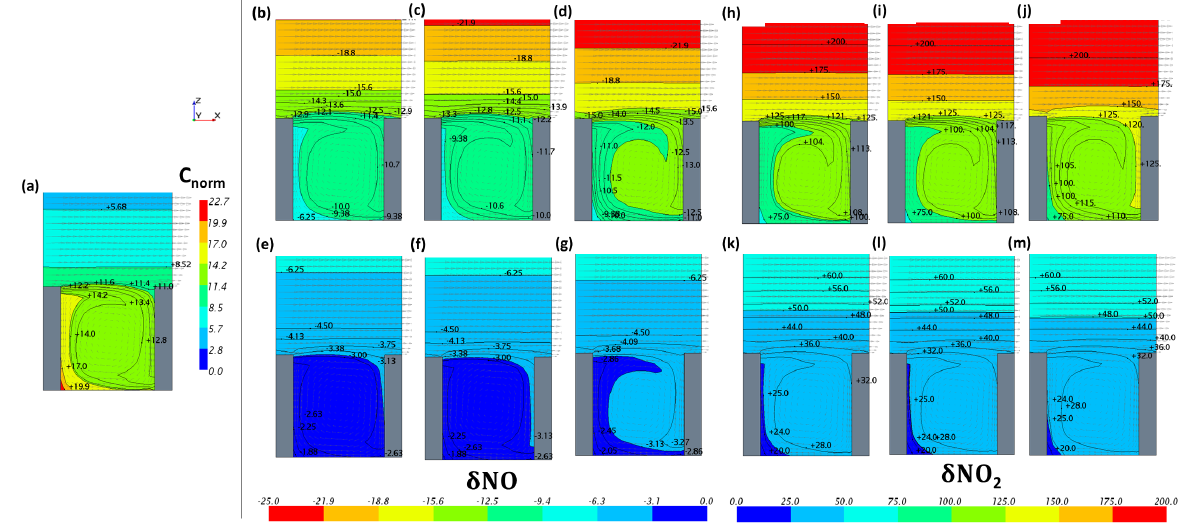
Figure 4. In the 2-D geometry: (a) distribution of the normalized concentration of tracer and (b – m) the δ NO and δ NO 2 for PSS, CCM1/5 and CCM1/2 are respectively depicted in (b – d) and (h – j) for case 2 and in (e – g) and (k – m) for case 4.